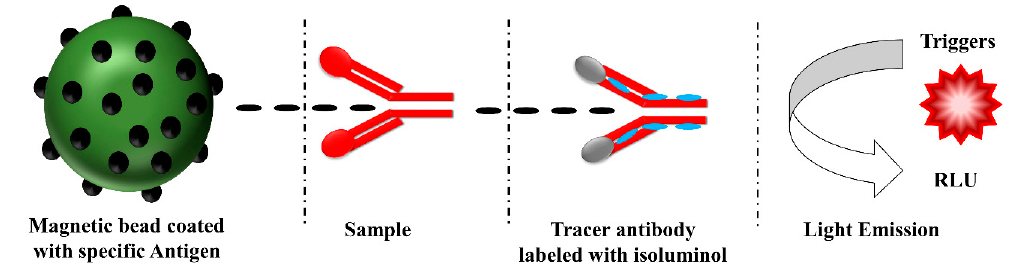
Figure 7. CIA principle in the diagnostic testing of autoantibodies [90].